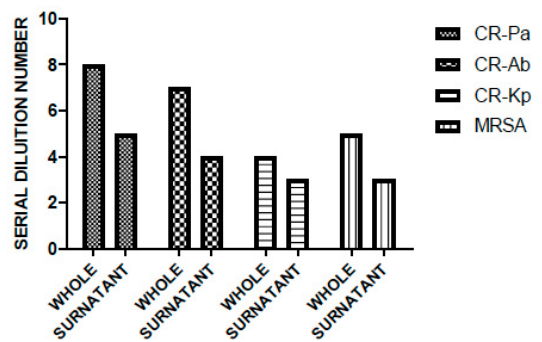
Figure 2. Antibacterial activity of probiotic whole compound (WP) and probiotic cell-free surnatant (PS) against clinical strains of carbapenem-resistant (CR) P. aeruginosa (Pa), CR A. baumannii (Ab), CR K. pneumoniae (Kp), and methicillin-resistant S. aureus (MRSA). The serial dilution number (y axis) corresponds to the number of the serial WP and PS dilutions needed to obtain the corresponding minimal bactericidal dilution (MBD). Results were expressed as mean. Standard deviation (SD) is not graphically represented, since the values of the experiments (performed in duplicate) were the same. In line with the results obtained at T0, the antibacterial activity of WP was higher than PS and especially noticeable against CR-Pa and CR-Ab. Following an incubation of 4 h, the MBDs of WP were 1:64 (SDN 6), 1:64 (SDN 6), 1:32 (SDN 5), 1:8 (SDN 3) vs. 1:16 (SDN 4), 1:16 (SDN 4), 1:8 (SDN 3), 1:4 (SDN 2) of PS for CR-Pa, CR-Ab, CR-Kp, and MRSA, respectively (Figure 3A). When incubating the WP and PS for longer, a lower antibacterial activity was overall observed, with a plateau obtained at 48 h and maintained up to 72 h (Figure 3A,B).